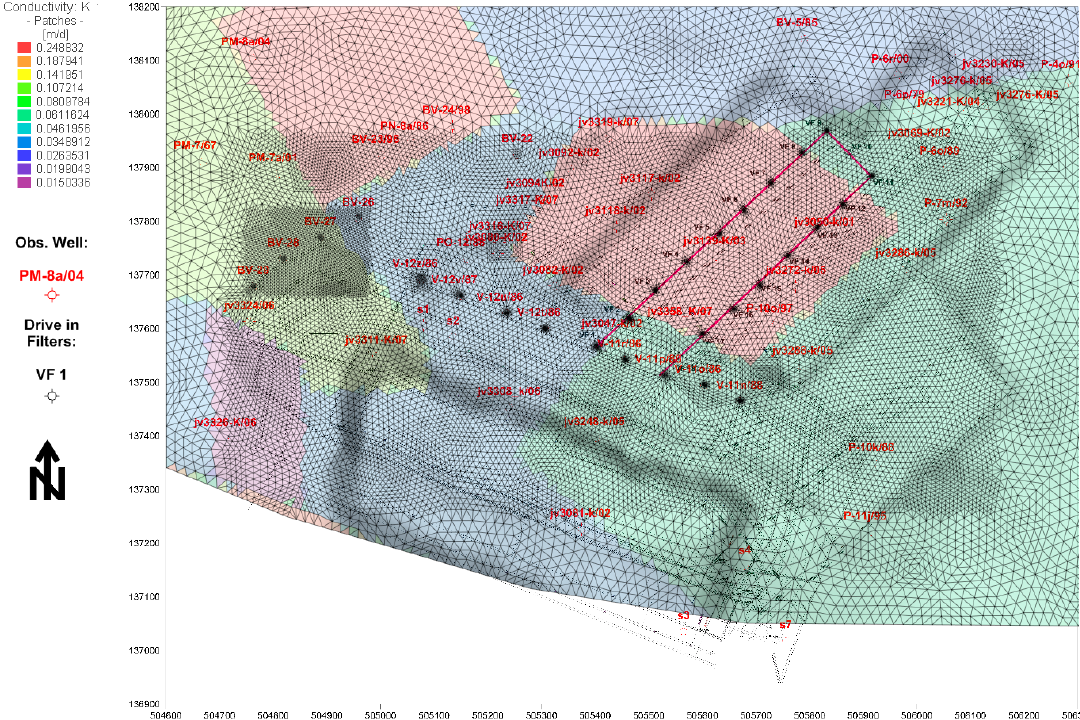
Figure 5. The hydraulic conductivity (k) areas values after the calibration in FeFlow 6.1.